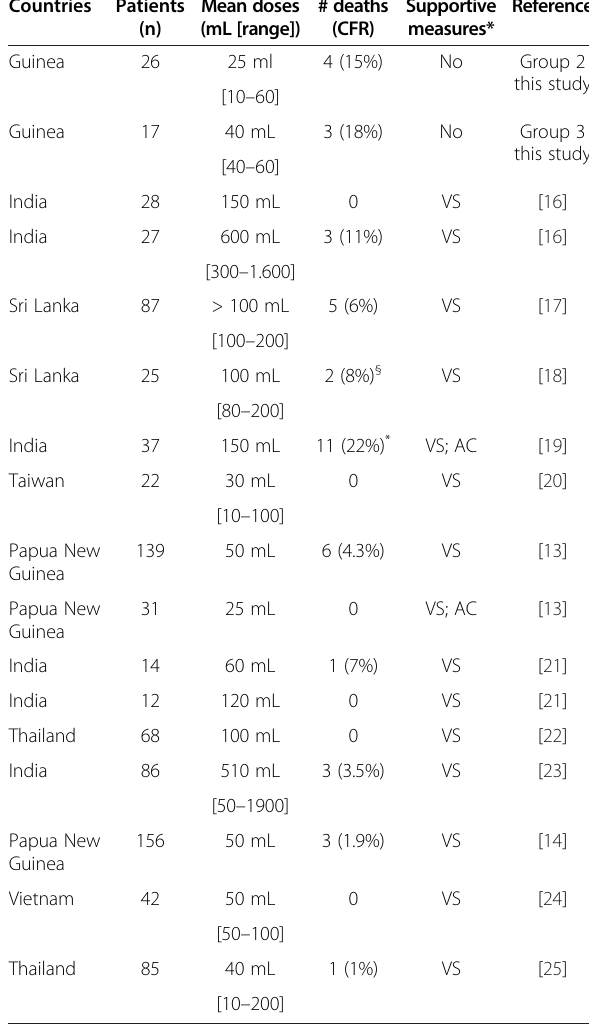
Table 7 Antivenom doses and mortality observed in the